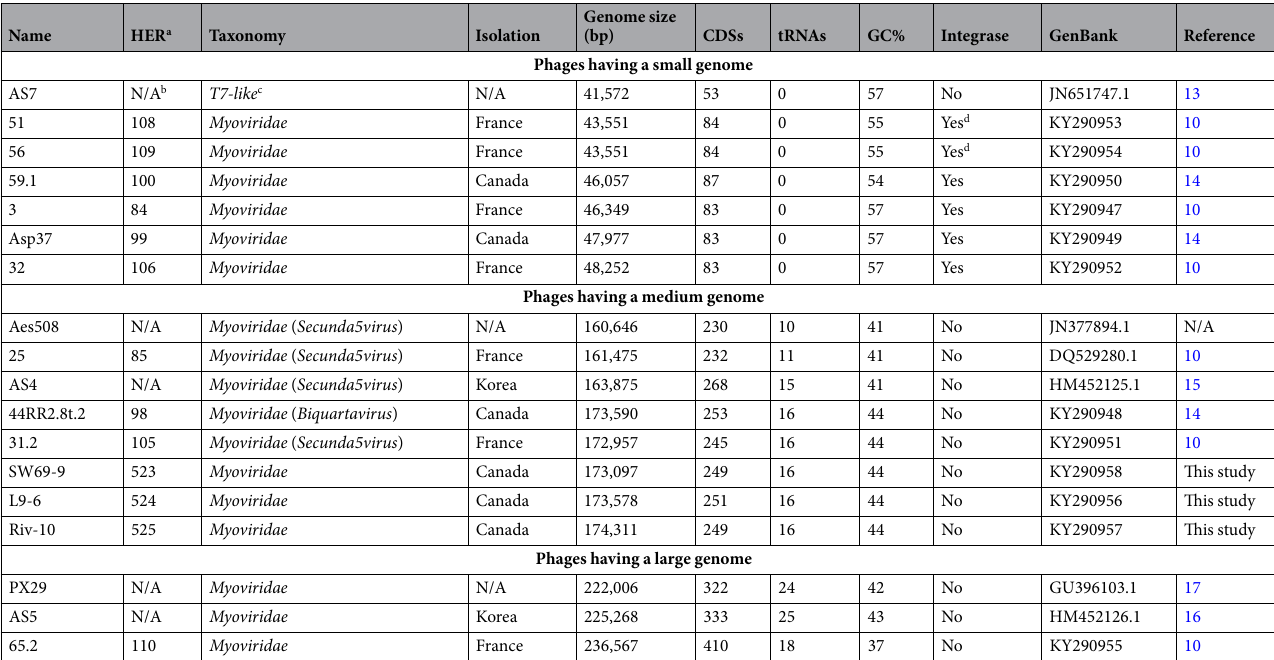
Table 1. Phages infecting A. salmonicida used in this study. a Refers to the Felix d’Hérelle collection (http:// www.phage.ulaval.ca) number. b Means none applicable. c Only based on bioinformatics inference. d Low confidence in the gene’s